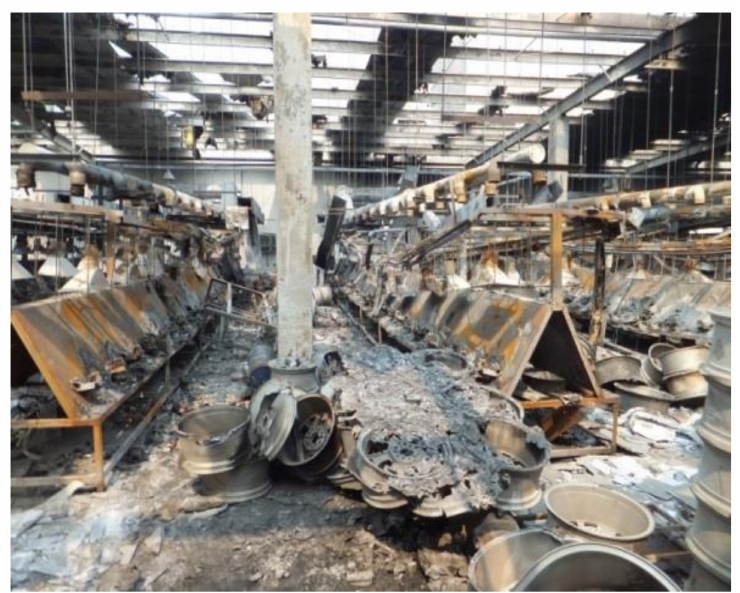
Figure 6. Destroyed process lines on the second floor. From Li et al. (2016). Copyright (2016), with permission from